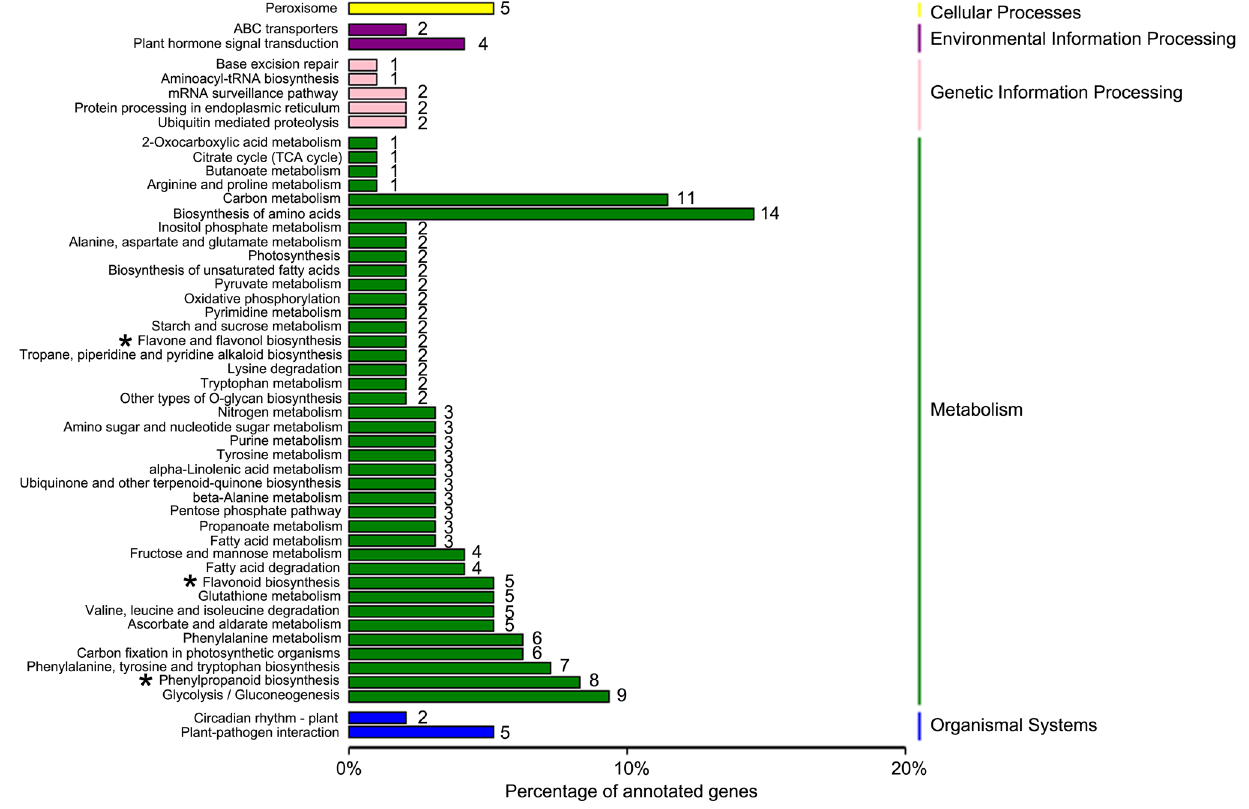
Figure 7. Kyoto Encyclopedia of Genes and Genomes (KEGG) pathway classification of differentially expressed genes (DEGs). The x-axis shows the proportion (%) of the total number of DEGs annotated that were annotated to a given pathway. The y-axis indicates each KEGG metabolic pathway name. The numbers indicate the number of DEGs annotated to each pathway. Single asterisks represent those pathways related to flavonoid